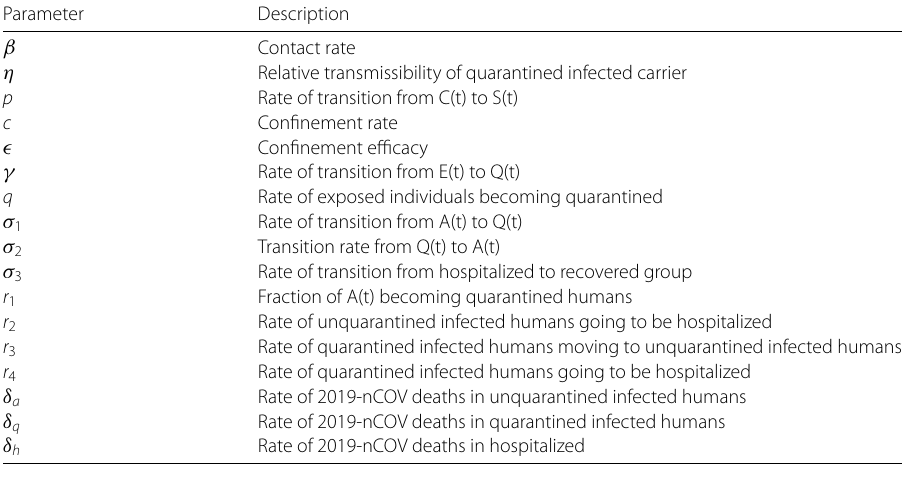
Table 1 Model parameters and their description